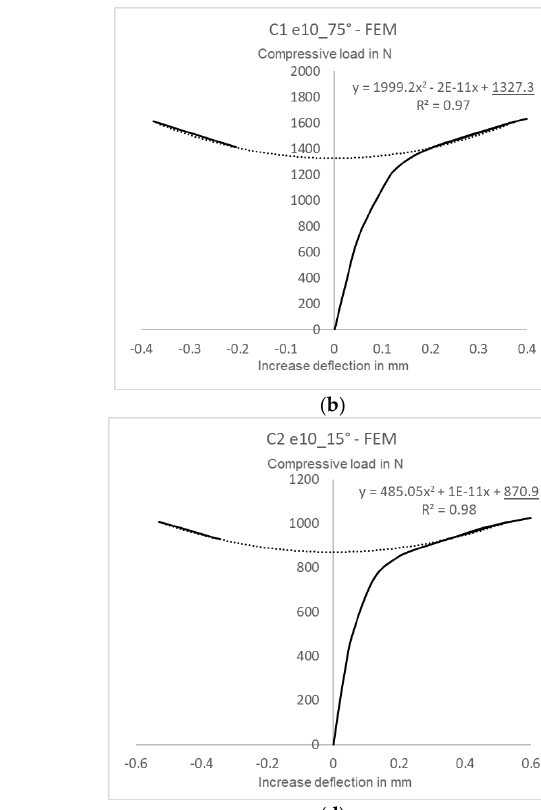
Table 2. Critical loads for structures with initial imperfections.